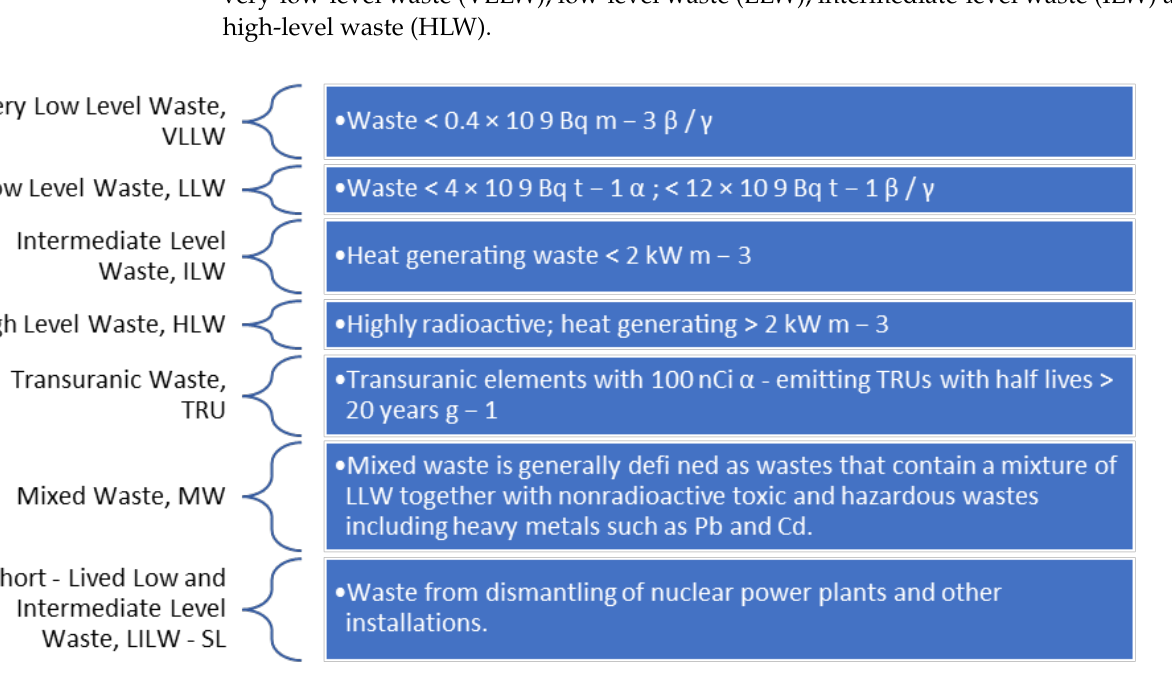
Figure 4. Different Categories of radioactive waste.